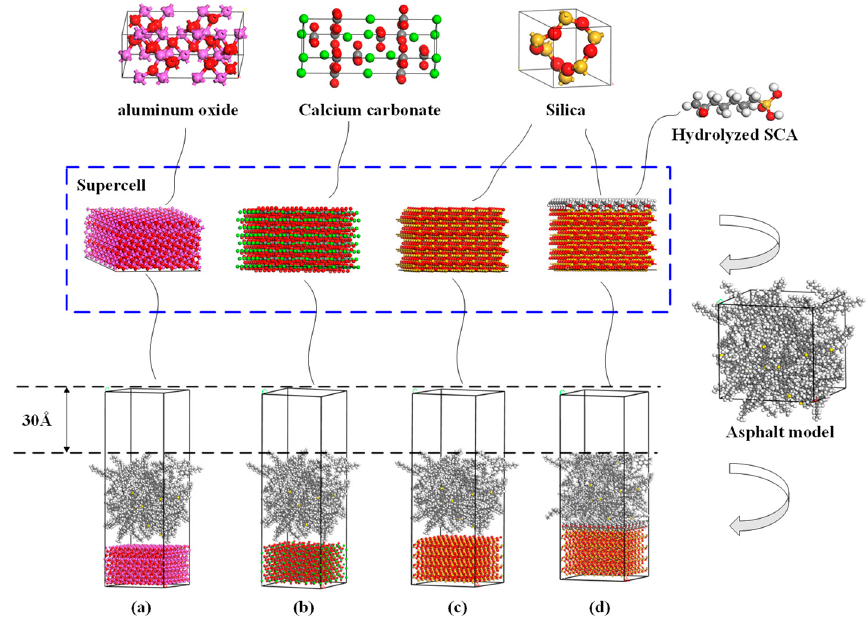
Figure 5. Process of building the model of ( a ) the basalt-asphalt, ( b ) the limestone-asphalt, ( c ) the granite-asphalt, and ( d ) the granite/SCA-asphalt.